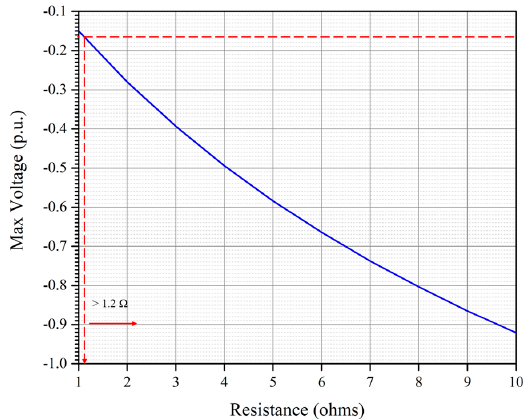
Figure 22. Maximum sheath-ground overvoltage at the entrance of the cable resulting from a lightning strike on OHGWs at the transition tower.